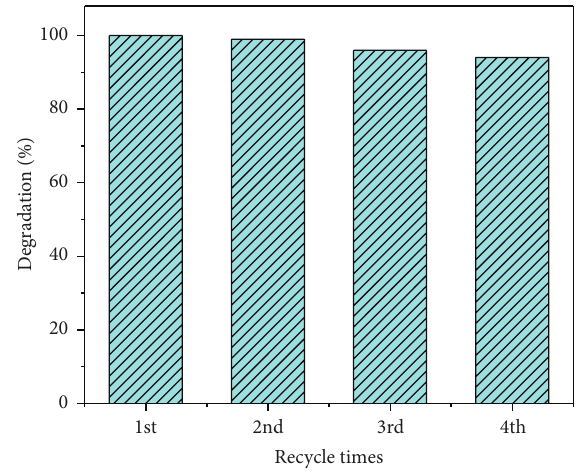
Figure 10: Degradation percentage of RhB in the presence of S1- 10: 10wt% TiO 2 /CdS (10h) under simulated sunlight irradiation for four recycles.